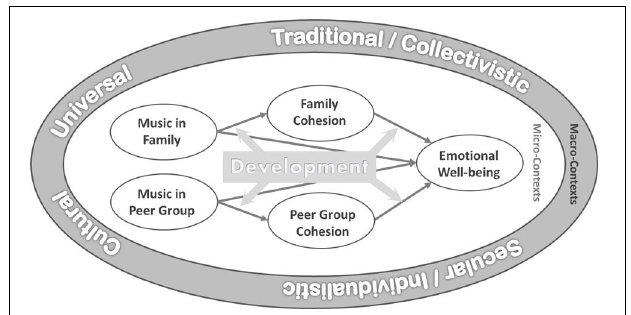
FIGURE 1 | Culture-sensitive developmental model of music in families and peer groups and their effects on family cohesion, peer group cohesion, and on emotional